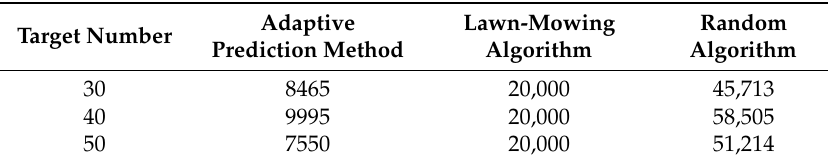
Table 1. Comparison of the cost of the search method.